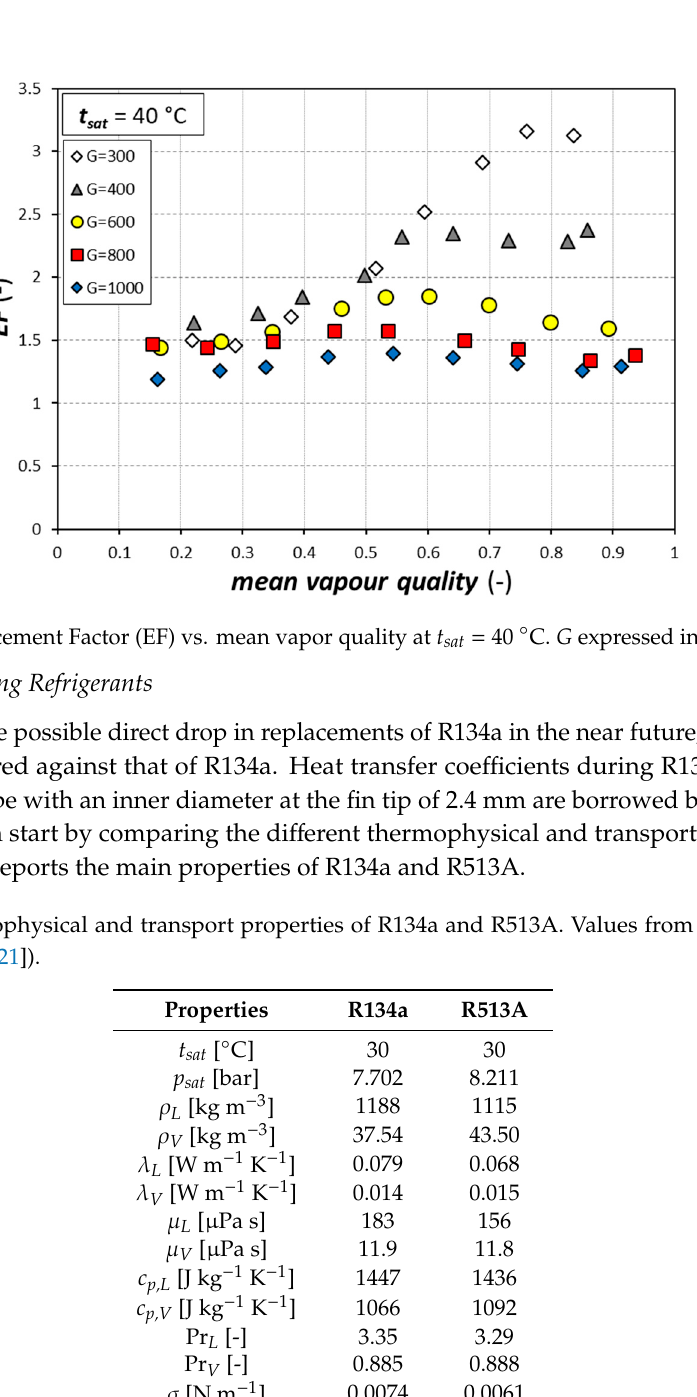
Table 1. Thermophysical and transport properties of R134a and R513A. Values from REFPROP 10 (Lemmon et al. [21]).